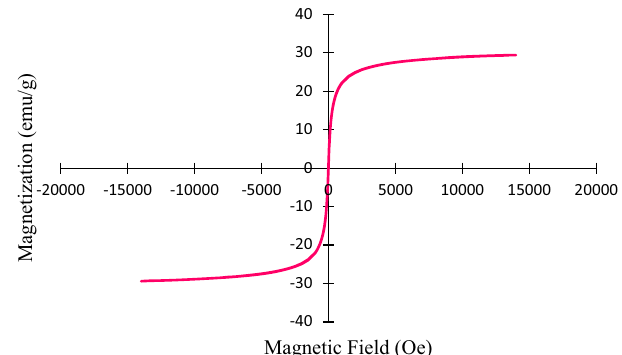
Figure 4. Magnetization curve of biochar/Fe 3 O 4 –Ag nanocomposite.